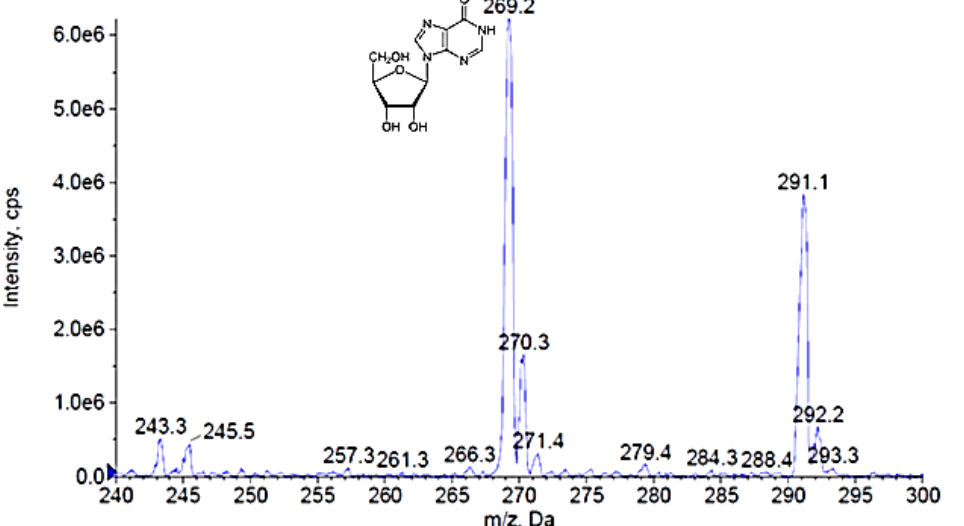
Fig. 2. The spectrum of the riboxinum